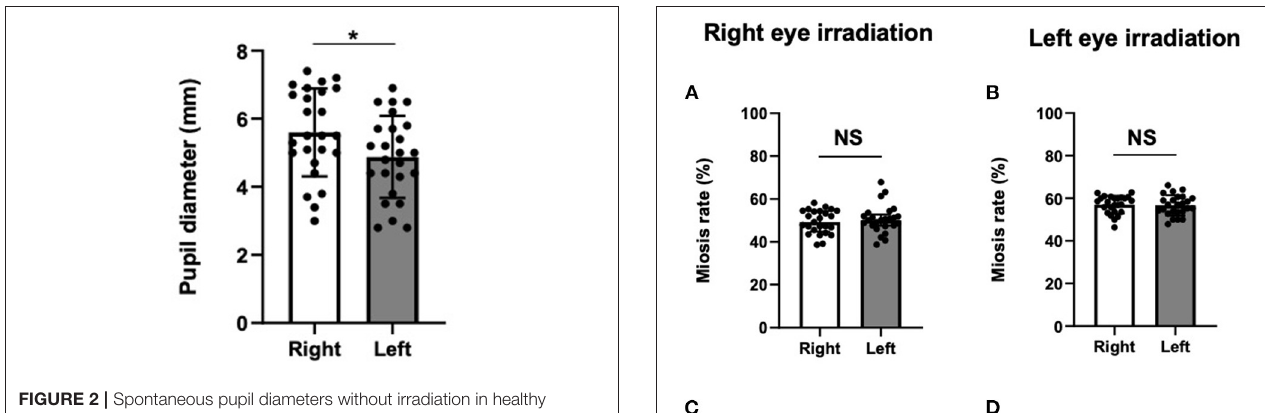
FIGURE 2 | Spontaneous pupil diameters without irradiation in healthy volunteers. Data are presented as the mean ± SD. Closed circles show data distribution. * P < 0.05. N = 25/group.